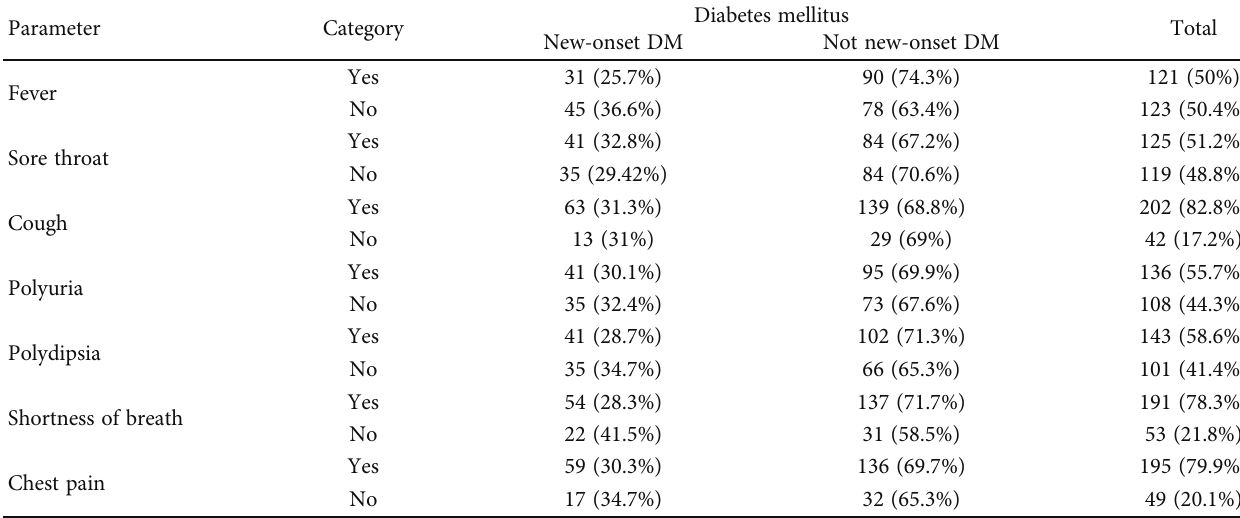
Table 3: Clinical characteristics of the study participants at the time of their admission to the COVID-19 care facility in Addis Ababa, Ethiopia, in 2022 ( N = 244